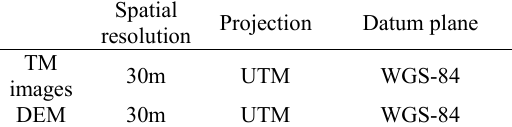
Table 1 The basic parameters of the experimental